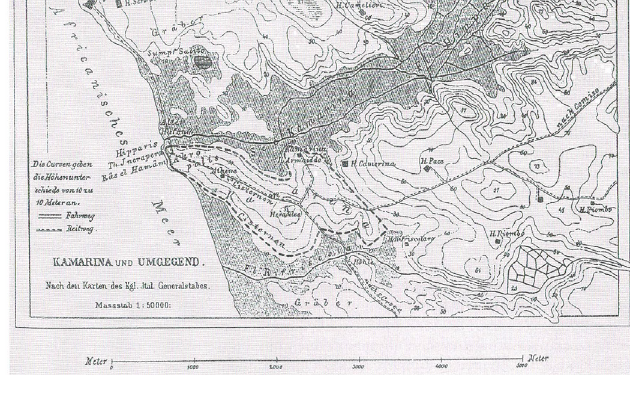
Fig. 12 Kamarina, planimetric sketch by A. Evans,